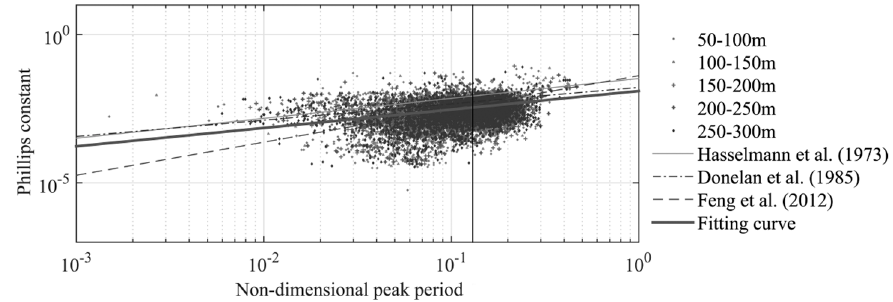
Figure 9. Values of as a function of υ for normal condition from 1999 to 2014. Three empirical Equations (4), (24) and (26) by Hasselmann (1973) [11], Donelan et al. [15] and Feng et al., (2012) [27] are shown. The vertical line drawn at υ = 0.13 marks the commonly adopted boundary between swell and wind wave.